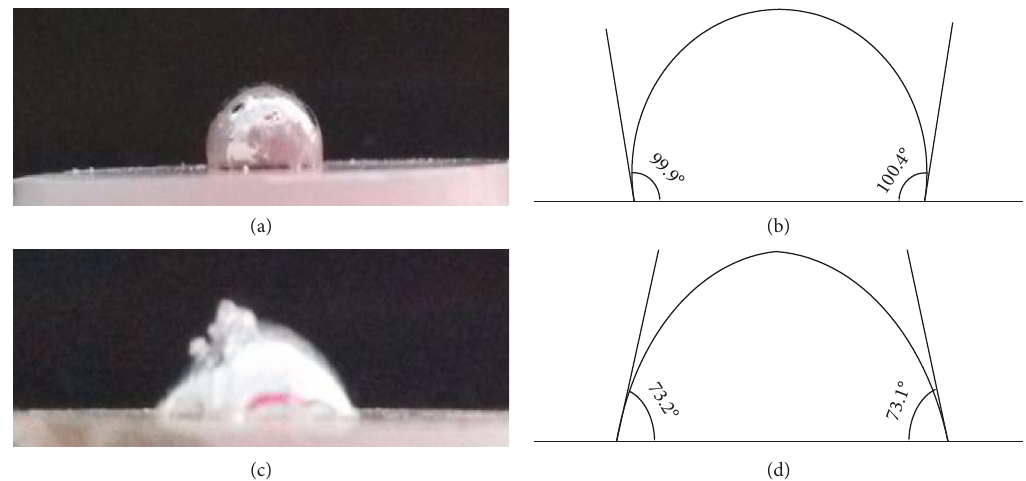
Figure 2: When the doped particle content was 1%, the wetting angle of (a, b) AgSnO